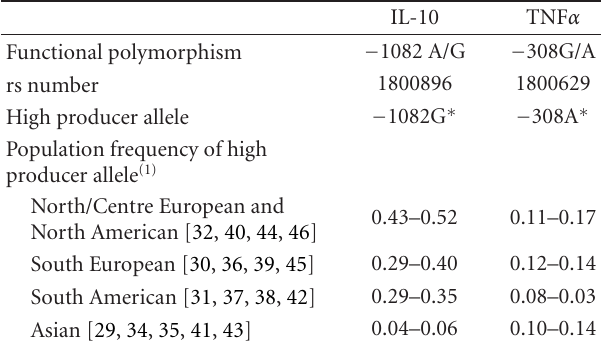
Table 1: Main functional IL-10 and TNF α SNPs involved in